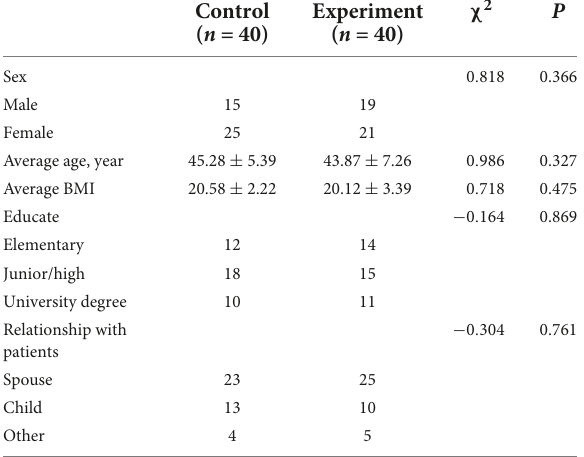
TABLE 1 Basic information about investigators.